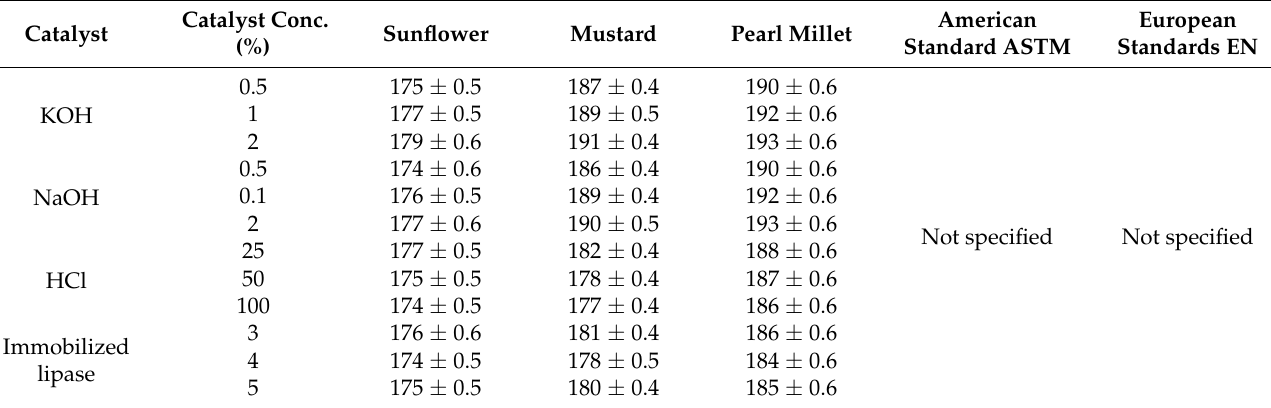
Table 2. Saponification value (mg KOH/1 g) of biodiesel from sunflower, mustard and pearl millet seed oils. Catalyst Catalyst